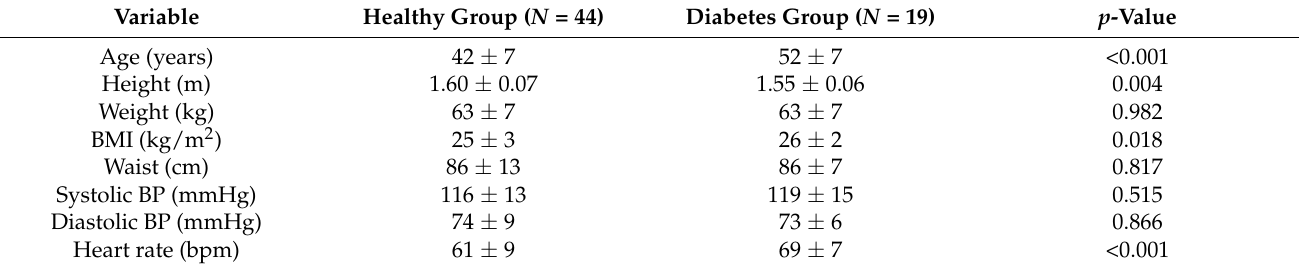
Table 1. Anthropometric characteristics of the study participants.